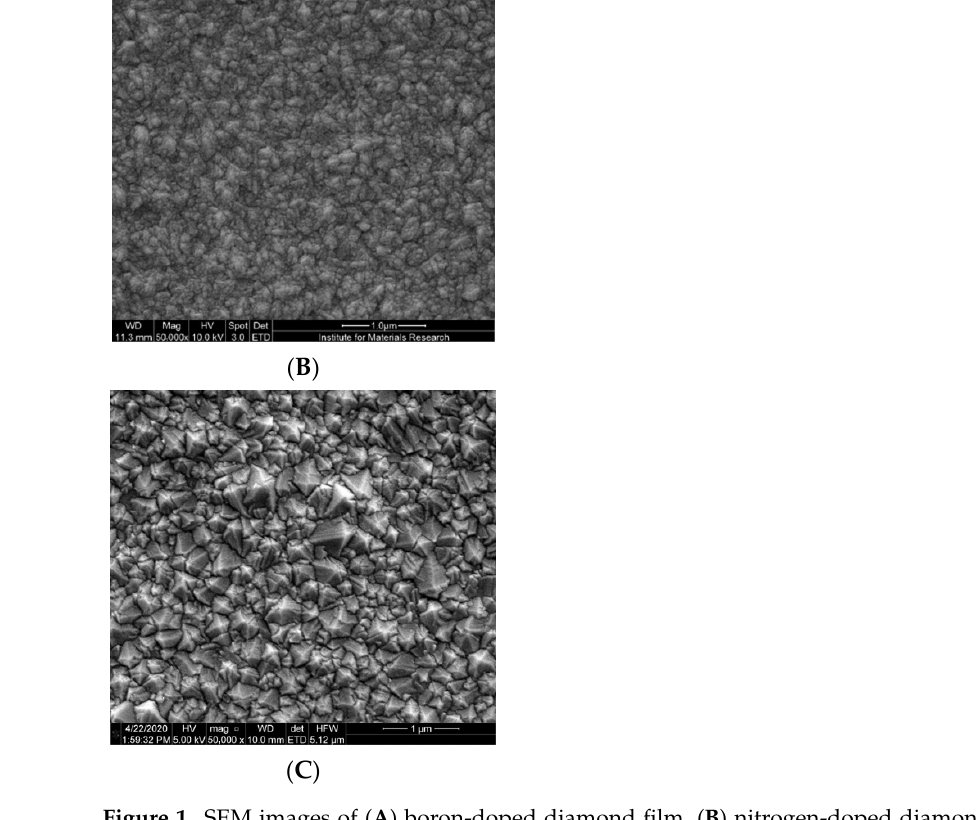
Figure 1. SEM images of ( A ) boron-doped diamond film, ( B ) nitrogen-doped diamond film and ( C ) nanocrystalline diamond sheet.